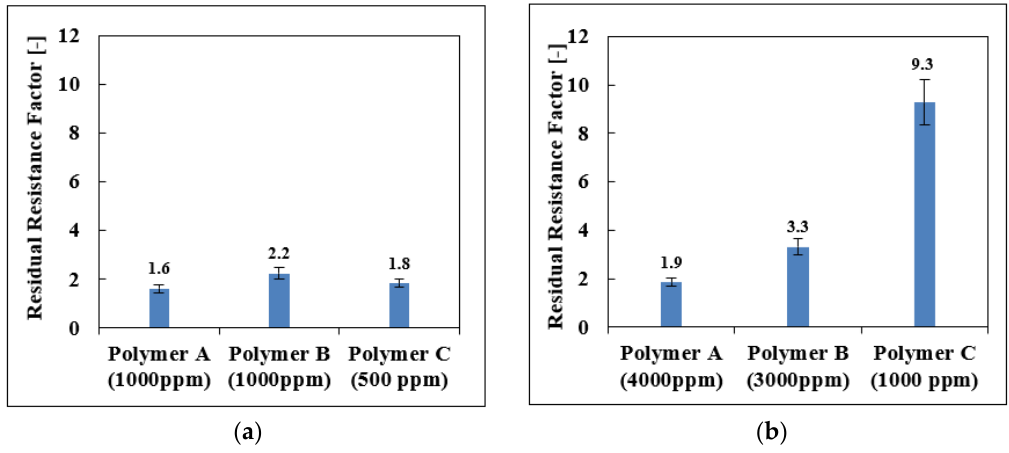
Figure 12 Residual resistance factor (RRF) of prefiltered polymers A, B and C. (a) Semi-dilute polymer Figure 12. Residual resistance factor (RRF) of prefiltered polymers A, B and C. ( a ) Semi-dilute polymer solutions; (b) Concentrated polymer solutions. solutions; ( b ) Concentrated polymer